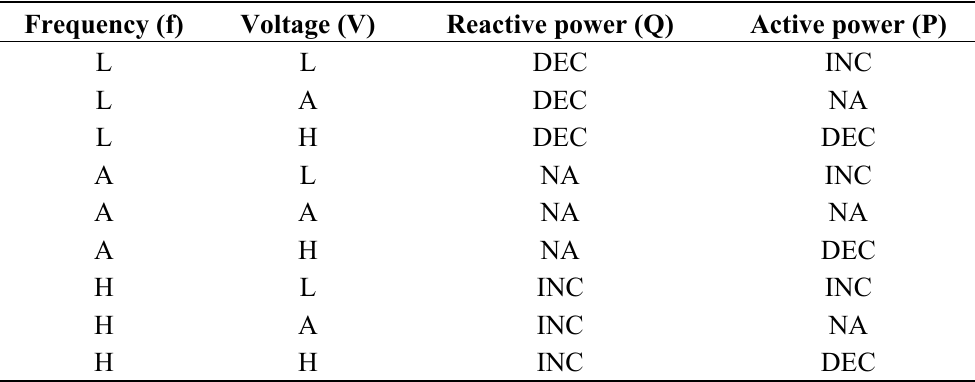
Table 1. control action